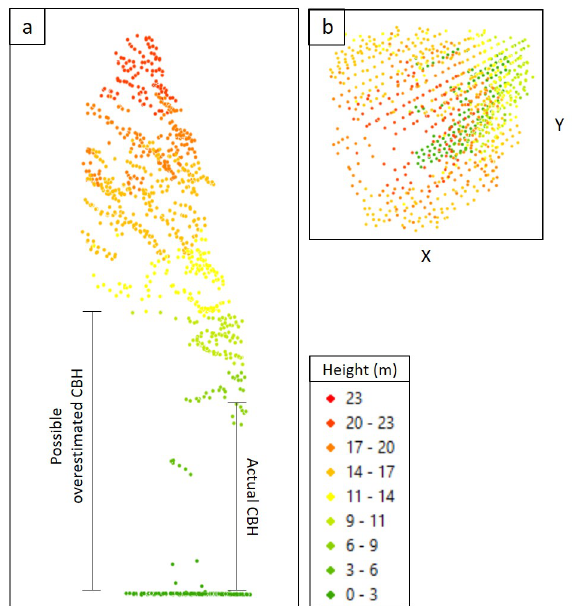
Figure 4. Example of a tree, only a part of which was extracted due to its’ location on the plot’s corner. ( a ) an illustration of the vertical cross section of the tree emphasizing the actual CBH and the one possibly estimated in case the tree points outside the plot’s border were not included in the analysis. ( b ) Vertical view of the tree showing the sides at which the tree was cut (i.e., upper and left